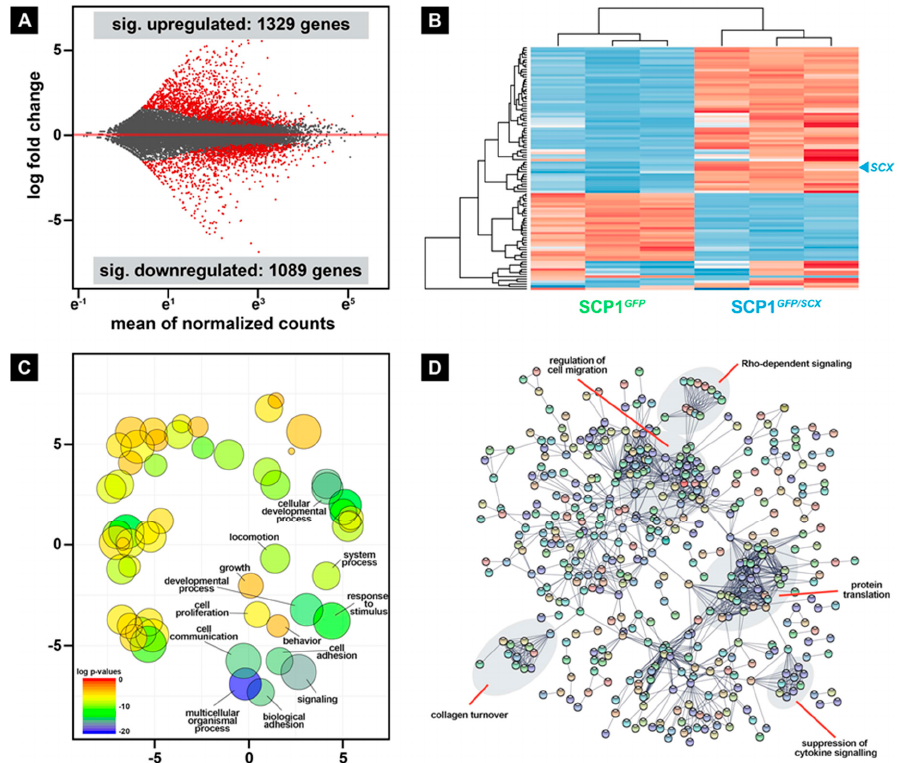
Figure 5. Di ff erential gene expression analysis revealed hundreds of significant up- and downregulated genes in SCP1 GFP / SCX when compared to normal SCP1 ( A ). Furthermore, hierarchical cluster analysis of the 100 most di ff erentially expressed genes clearly separates both cell lines ( B ). Gene ontology analysis of all significantly overexpressed genes in SCP1 GFP / SCX cells revealed several changes in biological functions ( C ) that also include collagen modifying genes, as well as released cytokines that are connected to cell migration ( D ). RNA-Seq data were obtained from three independent pellet preparations.